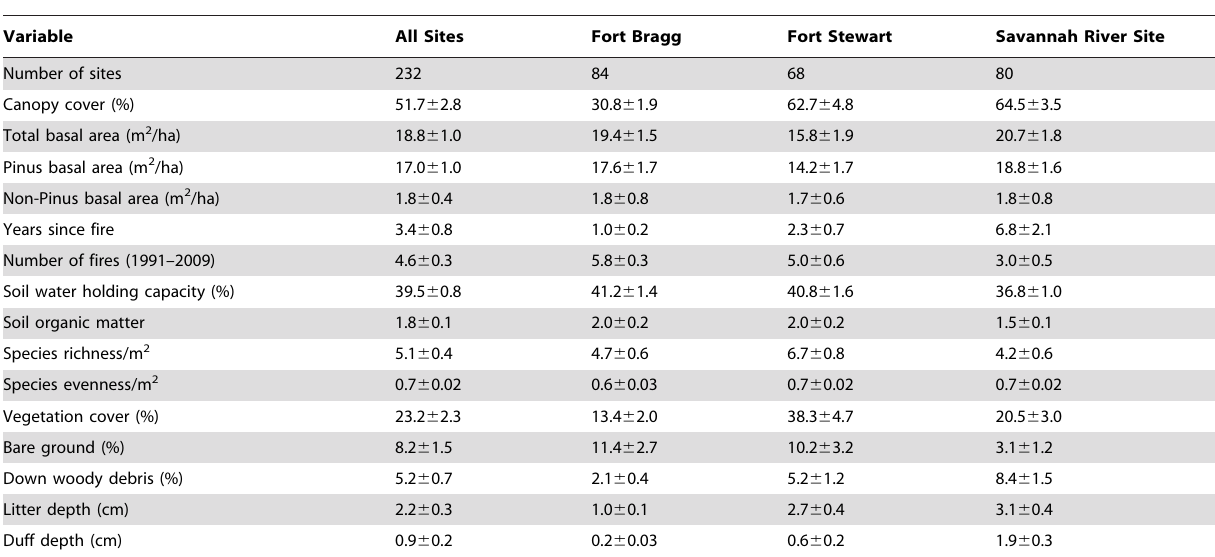
Table 1. Attributes across study sites and for each of the three study